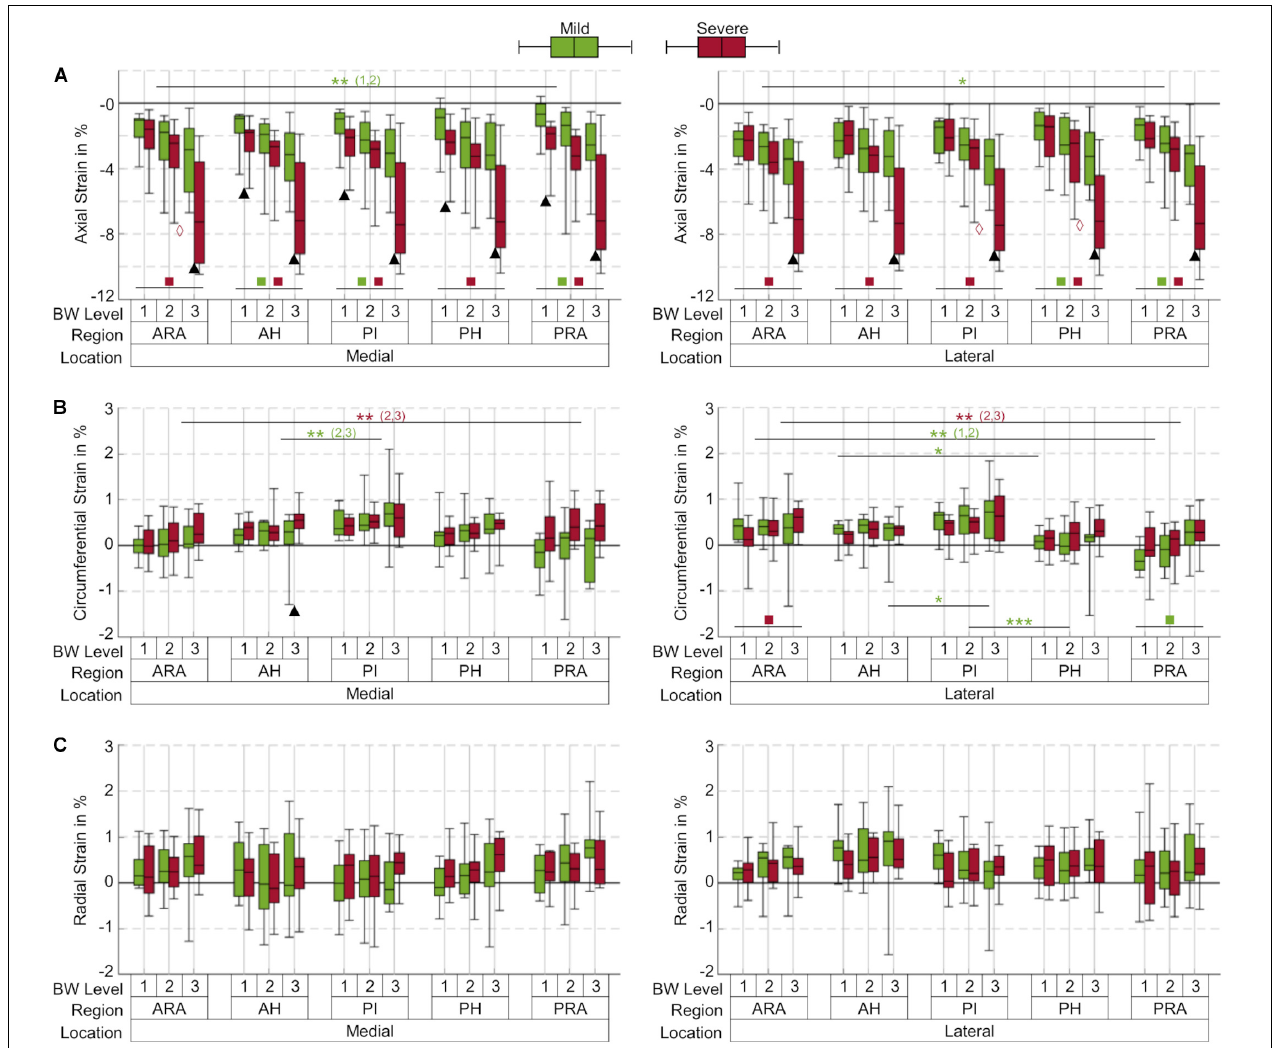
FIGURE 3 | Box plots (maximum, minimum, median, 25–75 percentile values) of axial (A) , circumferential (B) and radial (C) strains at three body weight (BW) levels (1 = 25%; 2 = 50%; 3 = 100% BW) in percent for the mild (green) and severe (red) degenerated group, subdivided into five anatomical regions (ARA = anterior root attachment; AH = anterior horn; PI = pars intermedia; PH = posterior horn; PRA = posterior root attachment). Positive values indicate tension; negative values indicate compression; n = 12 for each group and BW level, except for the mild degenerated group at 100% BW ( n = 10); (cid:78) indicates p ≤ 0.05 between the mild and severe degenerated groups at the respective BW level; * p ≤ 0.05; **(x,y) indicates p ≤ 0.05 between the corresponding compartments at BW level x and y regarding the respective group; ***indicates p ≤ 0.027 between the corresponding regions for all BW levels within the mild degenerated group; ♦ indicates p ≤ 0.049 between the BW levels 2 and 3 within the severe degenerated group; (cid:4) ( (cid:4) ) indicates p ≤ 0.044 ( p ≤ 0.002) between the BW levels 1 and 3 within the respective